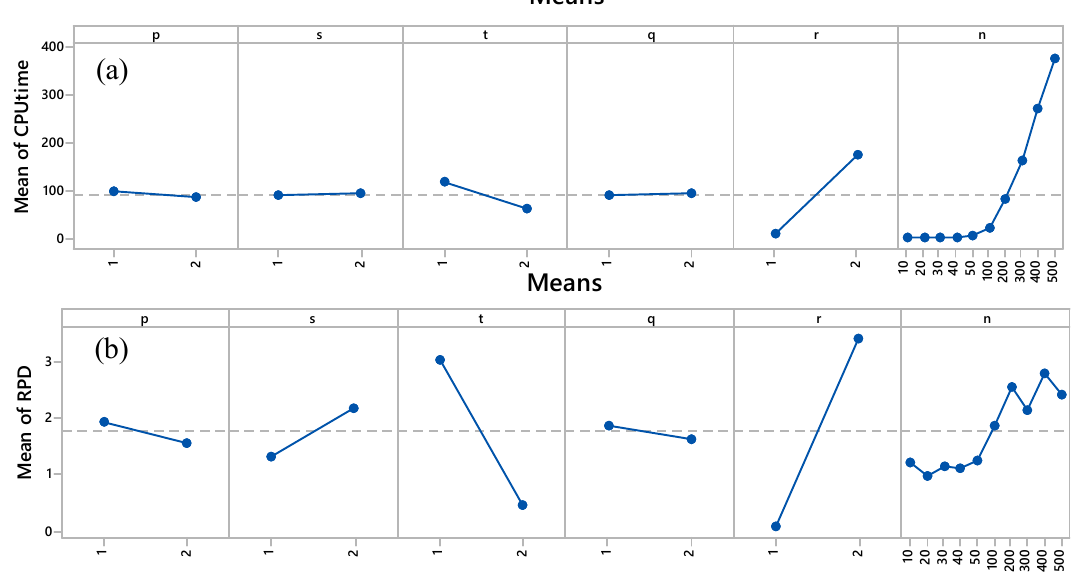
Figure 4. Main effects of the factors being studied on ( a ) the CPU time and ( b ) PRD. Figure 4. Main e ff ects of the factors being studied on ( a ) the CPU time and ( b )